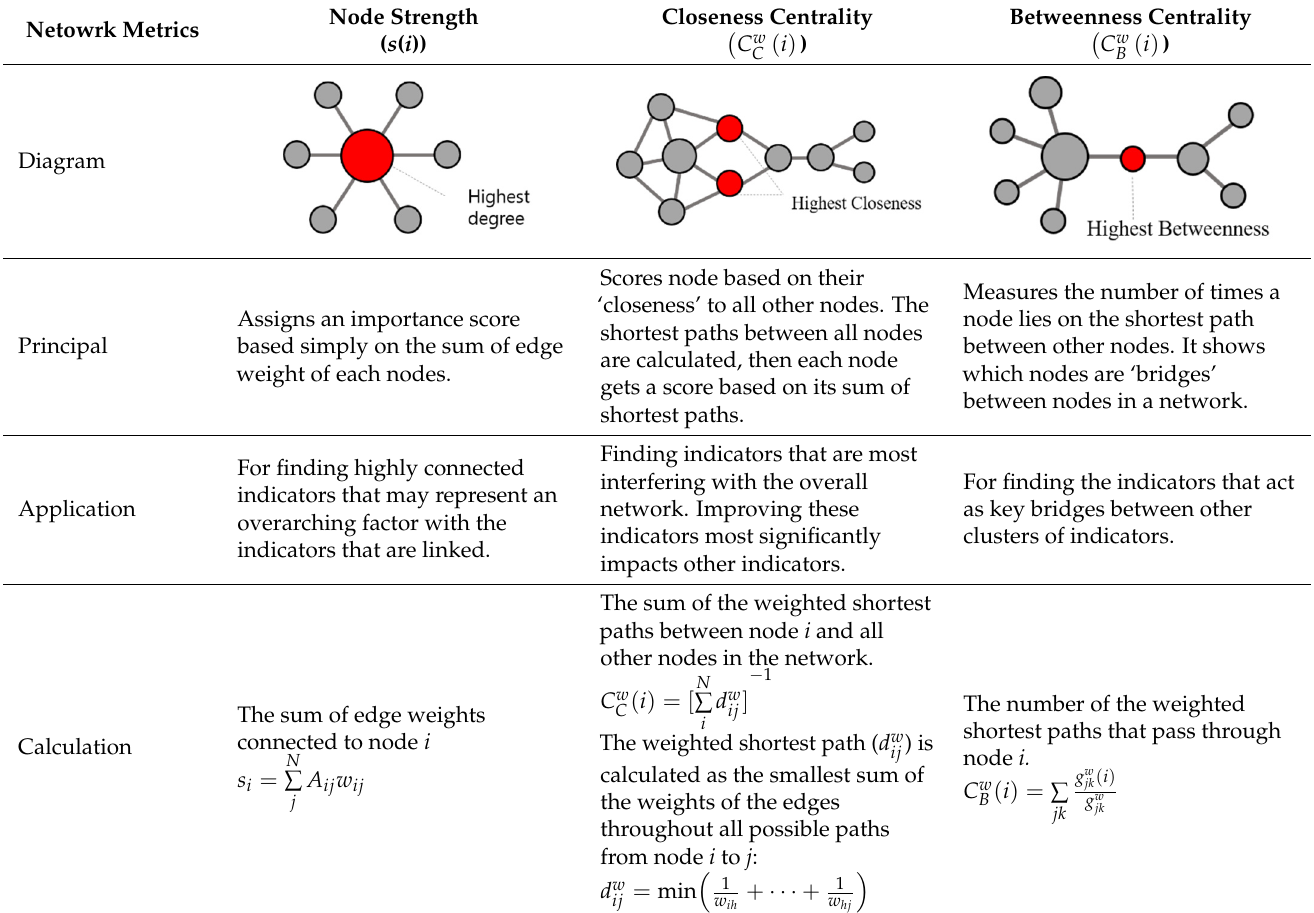
Table 3. The description of node strength, betweenness centrality, and closeness centrality.